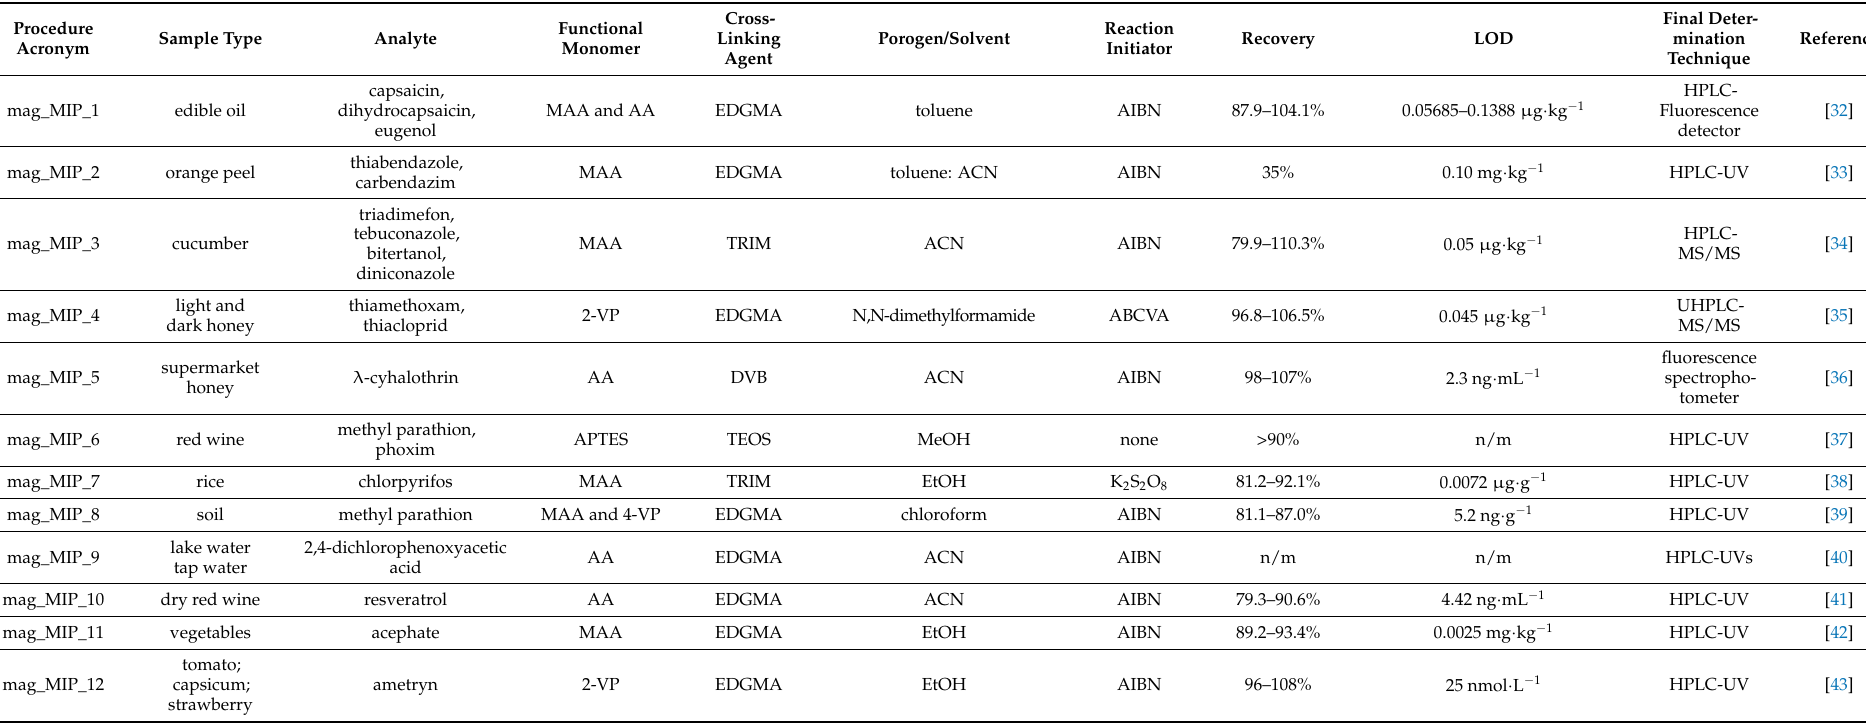
Table 3. Selected examples of application of magnetic MIPs (mag-MIPs) sorption materials in analytical procedures for the selective recognition of pesticide representatives in environmental and agricultural